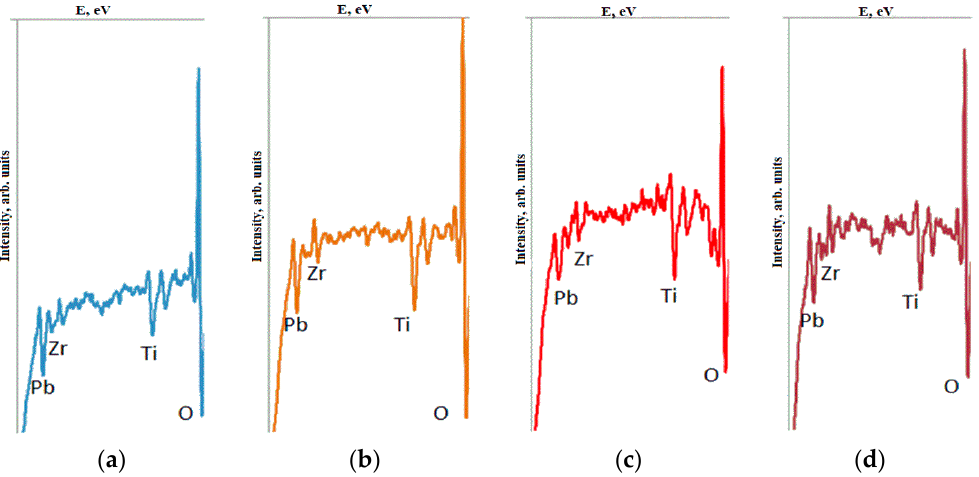
Figure 6. Auger spectra of PZT films: ( a ) after deposition; ( b ) after the formation of the perovskite phase; ( c ) after annealing in air; ( d ) after vacuum annealing. Table 3. Intensities of PZT films components signal determined on the basis of Auger spectra. PZT Films Pb O Ti Zr After deposition on the “cold” substrate After the formation of the perovskite phase